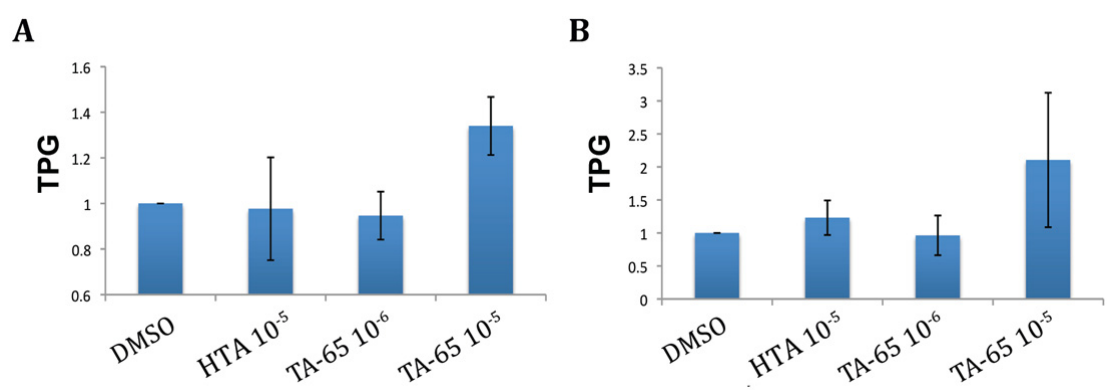
Figure 2. Average telomerase activity for a primary stimulation for ( A ) CD4 (n = 6) and ( B ) CD8 (n = 6) T cells. TPG is total product generated for telomerase activity. DMSO treated samples were used to normalized the TPG between the donors, which allow direct donor’s variability